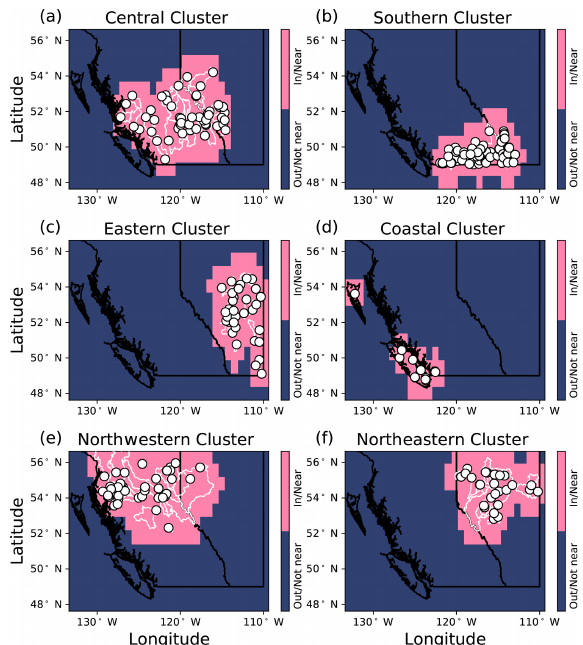
Figure A7. The areas of the study region which are within/near watersheds (pink) of each cluster and those which are outside/far from the watersheds (blue). Watershed boundaries are shown in white and are accessed through the Water Survey of Canada (Environment and Climate Change Canada,